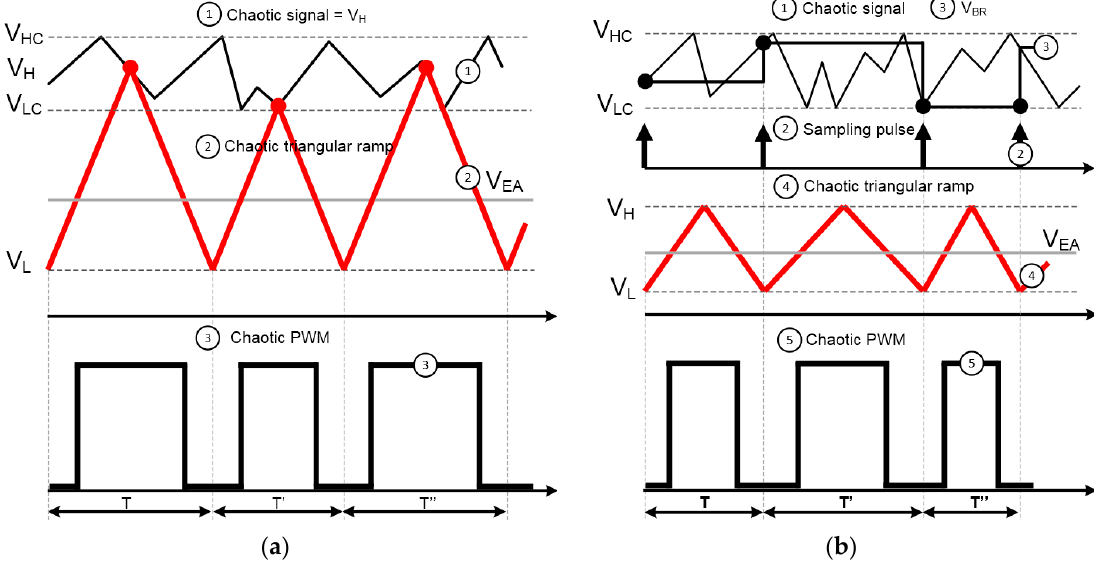
Figure 7. Modulation of chaotic triangular ramp signal: ( a ) peak modulation; ( b ) slope modulation.